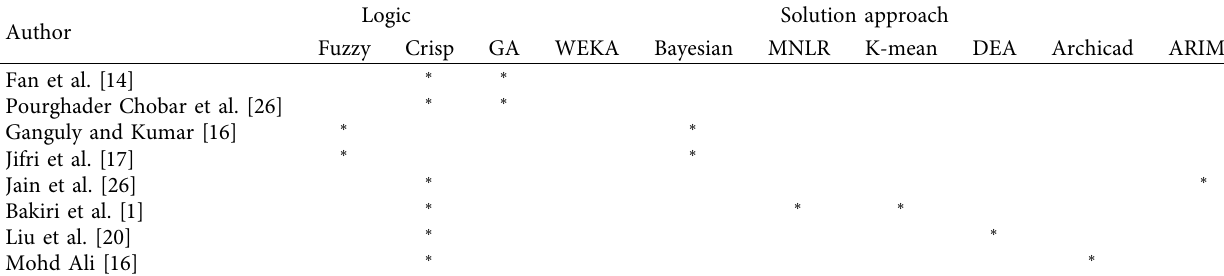
Table 1: Literature